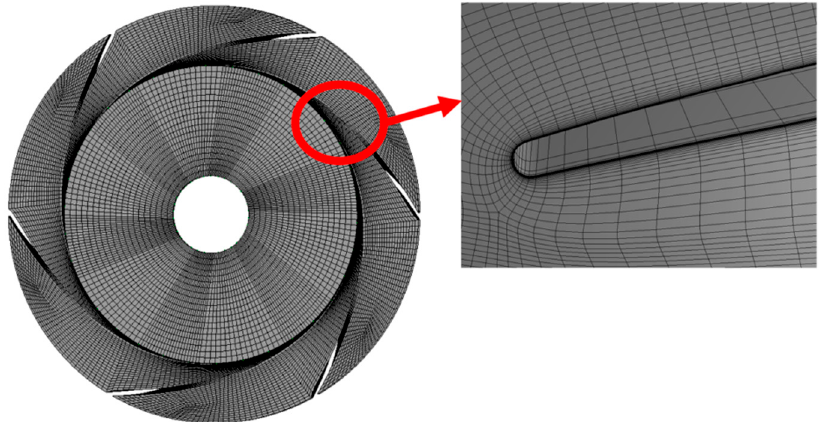
Figure 6. Grid distribution in an impeller.